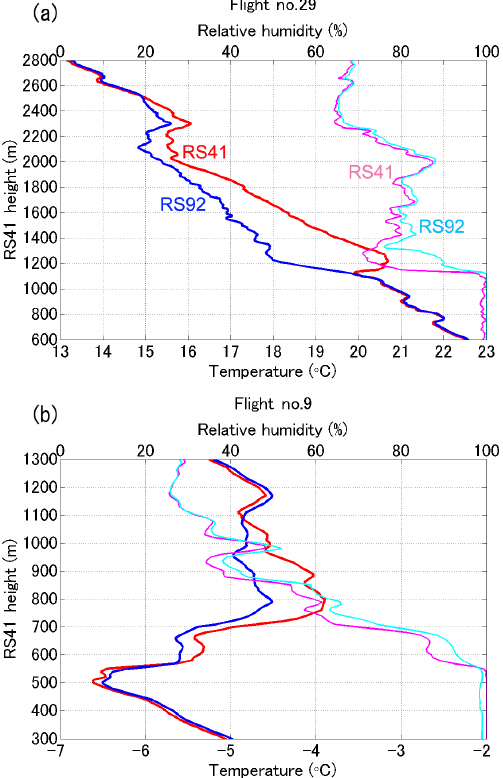
Figure 6. Vertical profiles of the RS41 temperature (red), RS92 temperature (blue), RS41 relative humidity (magenta), and RS92 relative humidity (cyan). (a) Flight no. 29 launched at 17:27UTC on 10 December 2015 in the tropics, and (b) flight no. 9 launched at 05:30UTC on 16 September 2015 in the